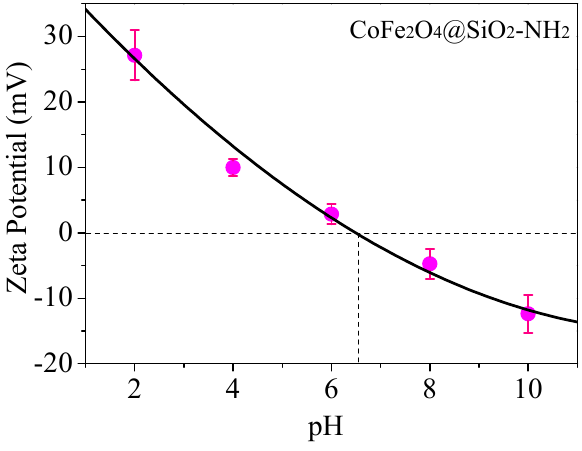
Figure 8. Zeta potentials under different pH conditions.